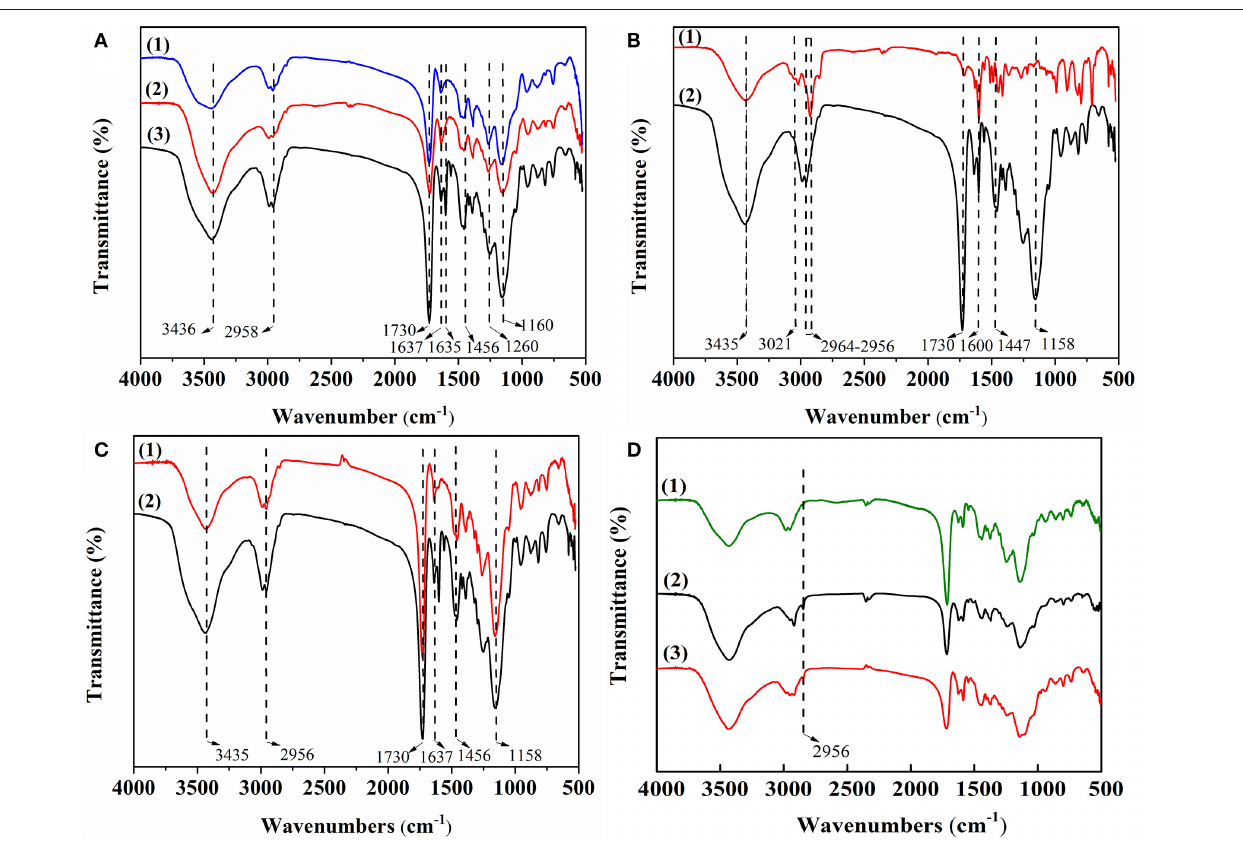
FIGURE 2 | (A) FT-IR spectra of MIPs with different functional monomers: (1) 4-VP of MIP1; (2) MAA of MIP2, and (3) HEMA of MIP3; (B) FT-IR spectra of MIPs with different cross-linkers: (1) DVB of MIP4 and (2) EGDMA of MIP1; (C) FT-IR spectra of MIPs with different solvents: (1) MIP5 and (2) MIP1; (D) FT-IR spectra of (1) NIP1, (2) MIP1-ACT, and (3)